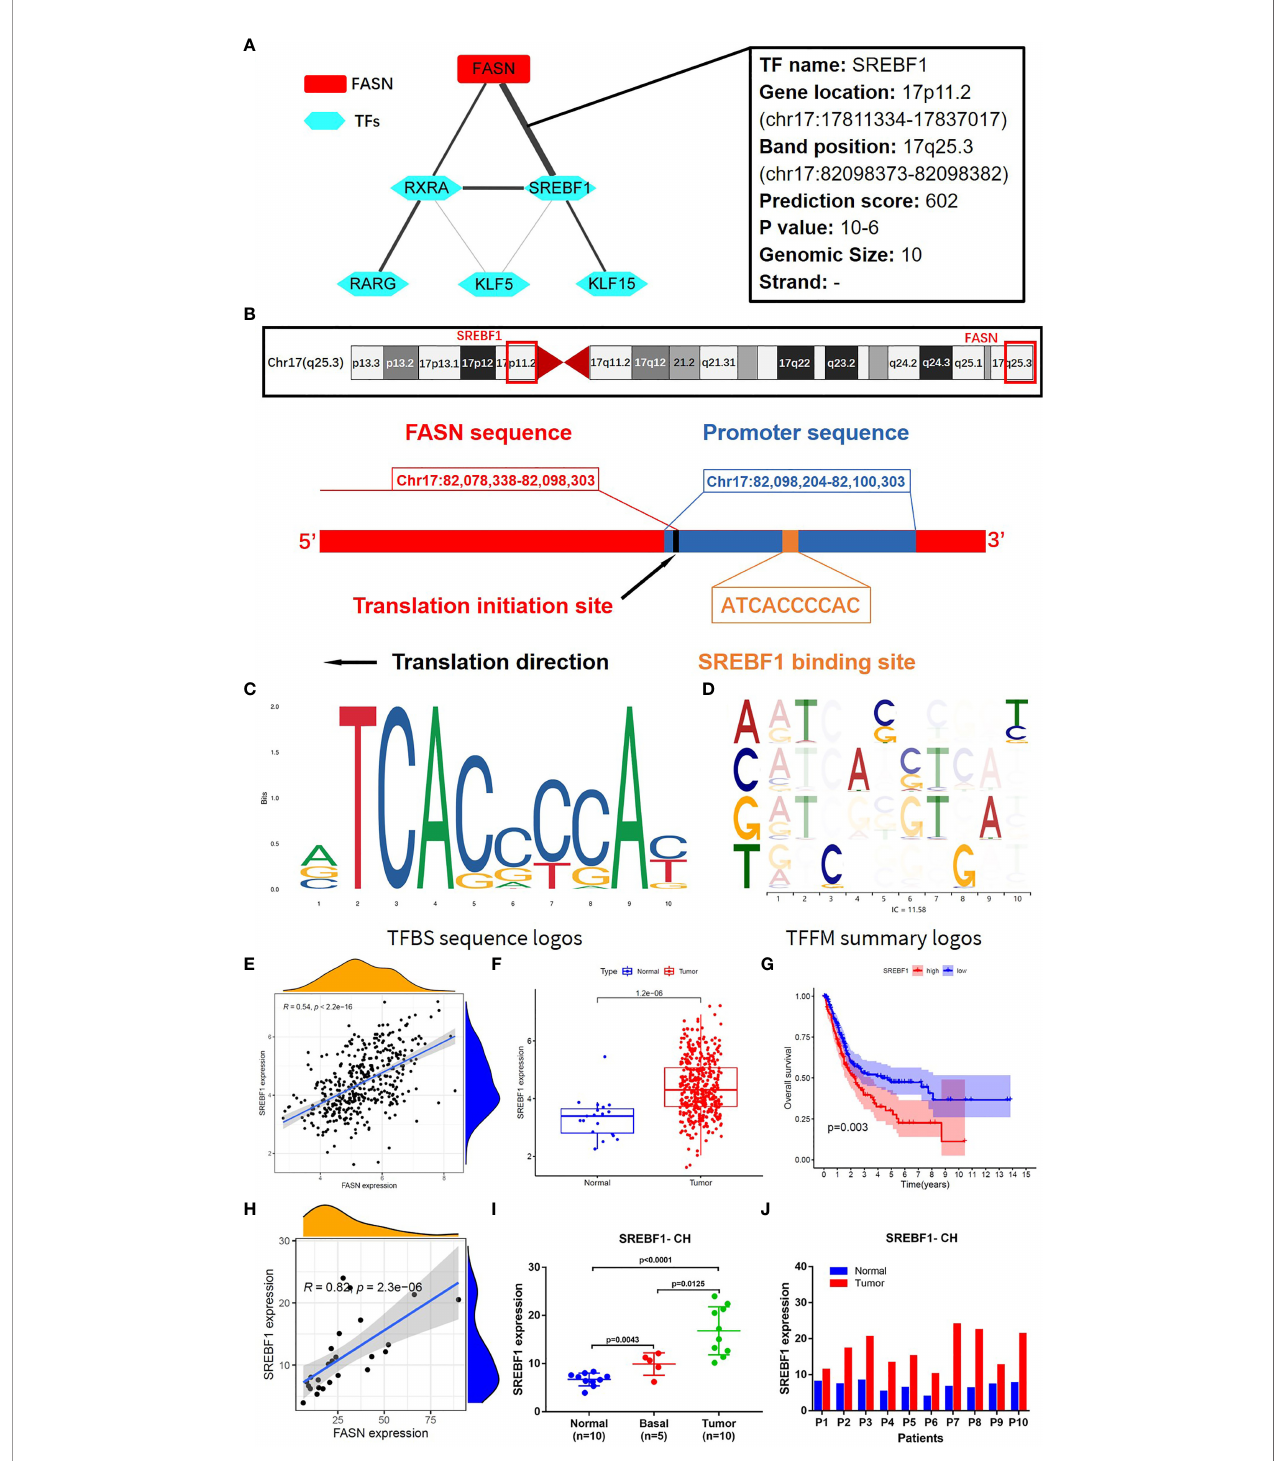
FIGURE 6 | Transcription factors regulating FASN. (A) Correlation network of FASN and TFs. (B) Diagram of gene location and transcription of FASN and SREBF1. (C) TFBS sequence logos of SREBF1 (the ordinate represents the amount of base information, and the abscissa represents the base location). (D) Base correlation logos of TFBS by TFFM. (E) Scatter plot of association between FASN and SREBF1 in TCGA. (F) Boxplot of SREBF1 expression in normal and tumor patients in TCGA. (G) Overall survival curve of low- and high-SREBF1 groups in TCGA. (H) Scatter plot of association between FASN and SREBF1 in CH database. (I) Differential expression of FASN in normal, basal and tumor tissues. (J) Differential expression of FASN in 10 paired normal and tumor